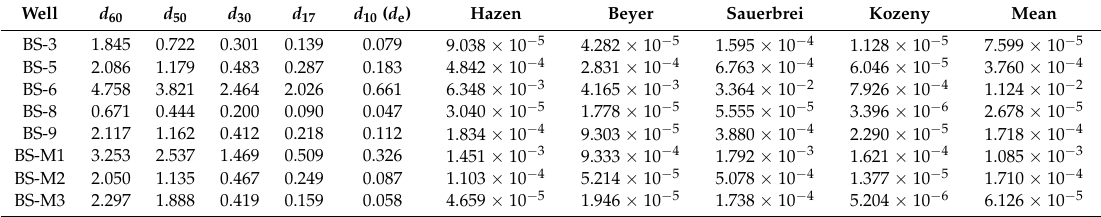
Table 9. The hydraulic conductivity values that were estimated using slug tests (unit: m/s).